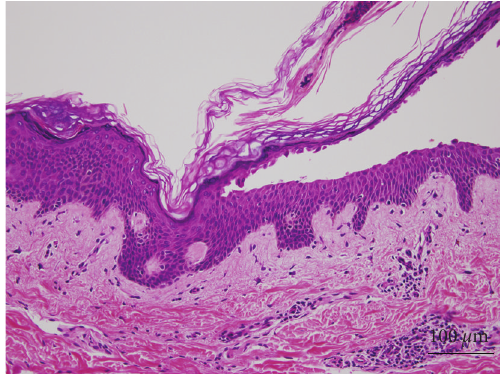
Figure 1: Blisters and erosions on the buccal mucosa, tongue, and lips. Oral lesions did not extend onto the vermillion of the lips.